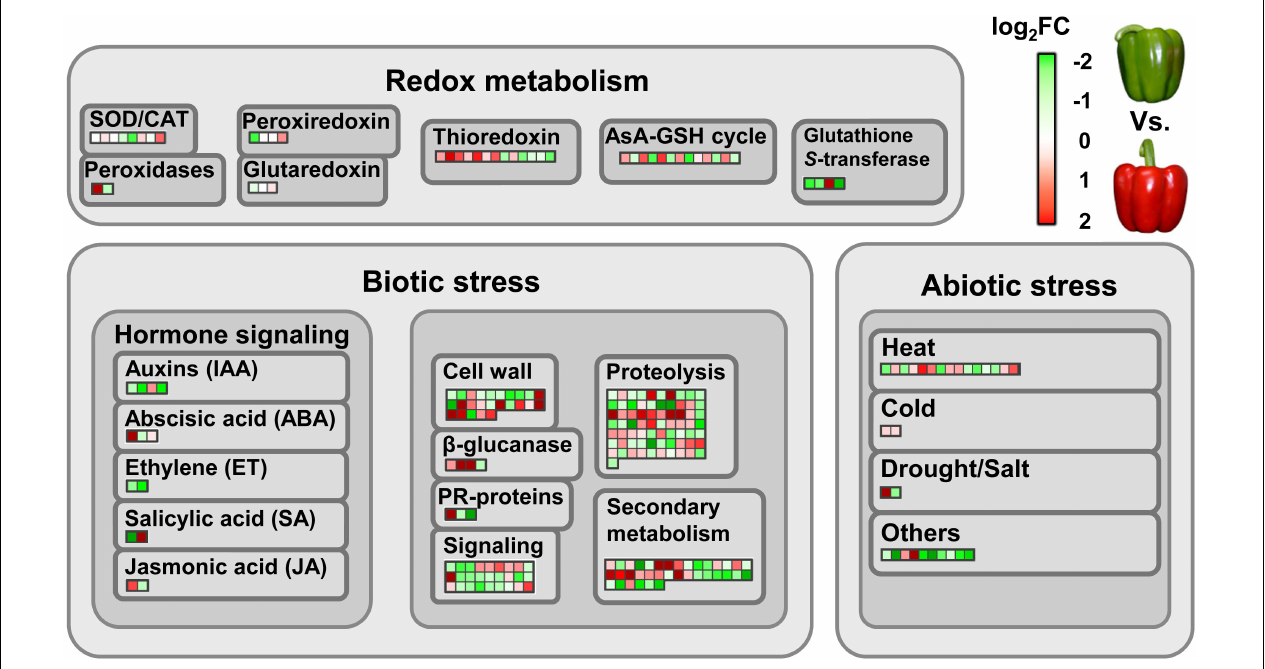
FIGURE 2 | Differentially abundant proteins involved in redox metabolism and (a)biotic stress responses during the ripening sweet pepper fruits. Each colored square represents a protein. Green and red colors indicate down- and up-regulation at fruit ripening, respectively, according to log 2 FC values. FC, fold change. In the above right scale, red means log 2 FC > 0, whereas green means log 2 FC < 0. AsA-GSH cycle, ascorbate-glutathione cycle; CAT, catalase; PR-proteins, pathogenesis-related proteins; SOD, superoxide